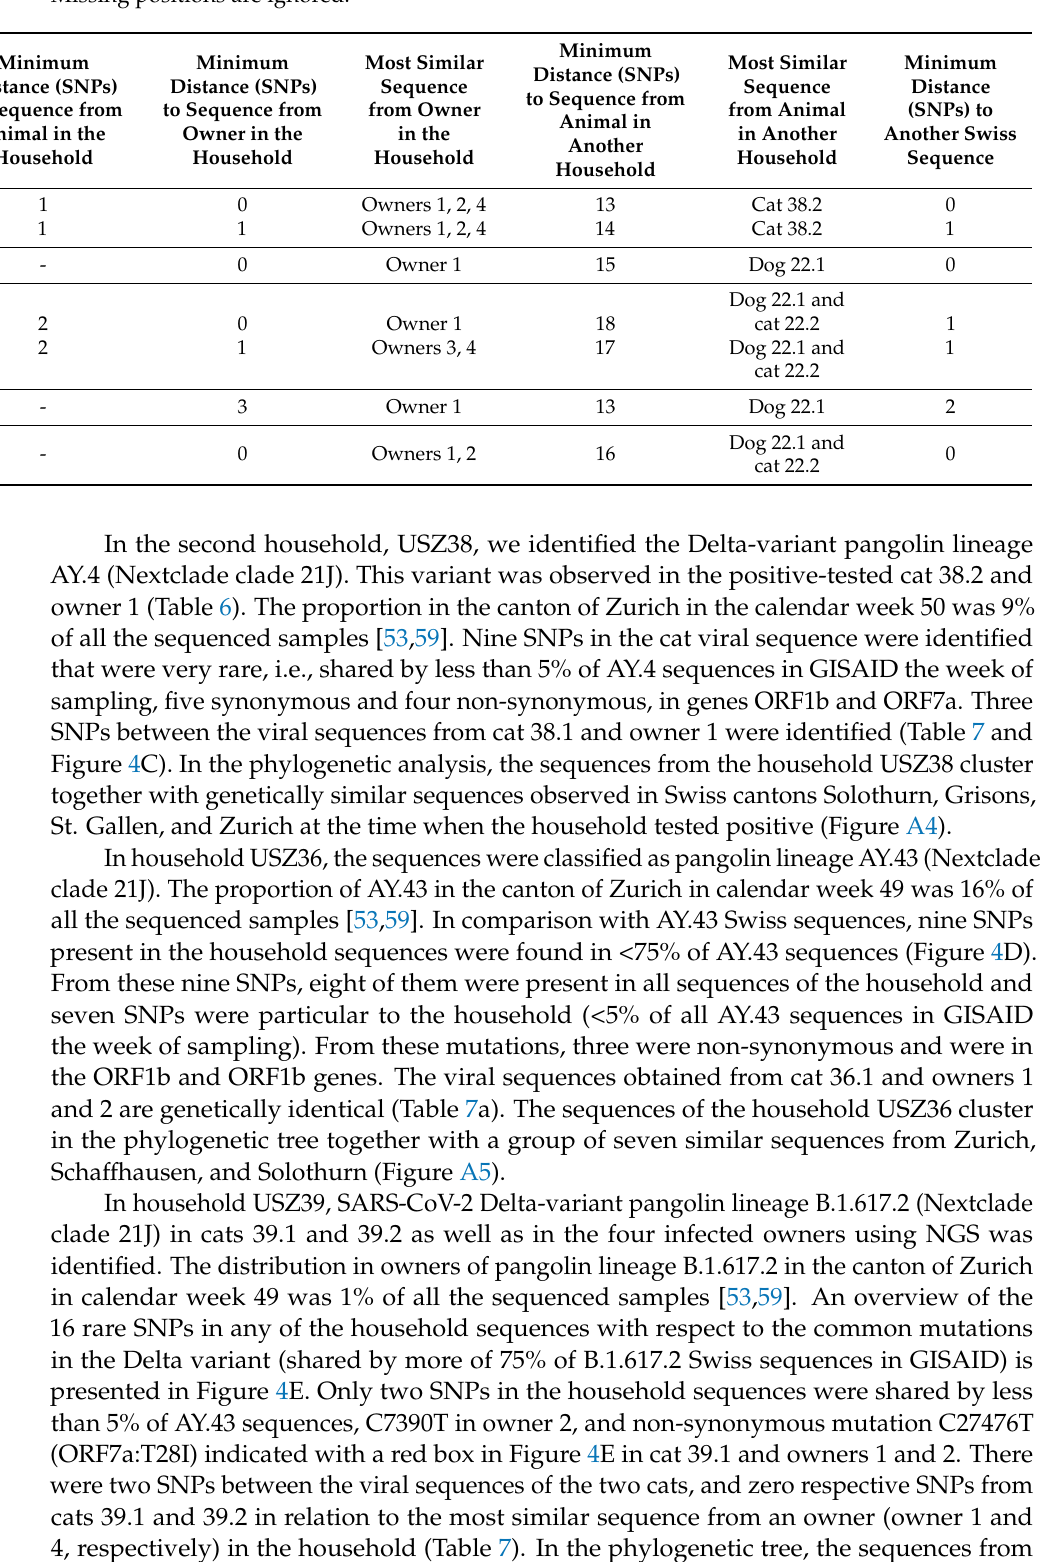
Table 7. Overview of the SNP differences between animals and owners within the household, animals within the household as well as in the other households, and animals and other human sequences in GISAID. Pairwise distance is measured as the number of sites that differ between the two sequences. Missing positions are